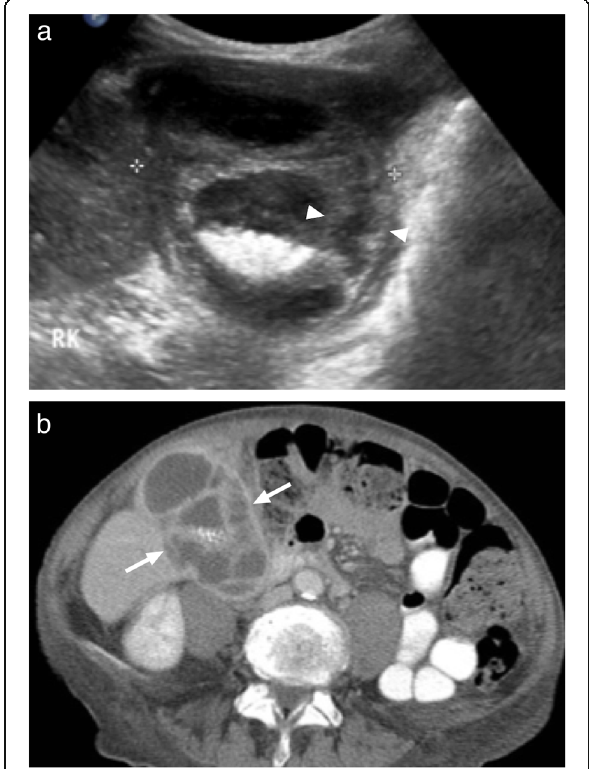
Fig. 24 A 45-year-old male presenting to emergency room with mild fever and right upper quadrant pain. a US image shows significant and irregular gallbladder wall thickening (arrowheads) and hyperechoic luminal debris. b Postcontrast axial plane CT image mimicking a multicystic mass (arrows) within the gallbladder fossa as well as intense contrast enhancement within the lesion wall. Open